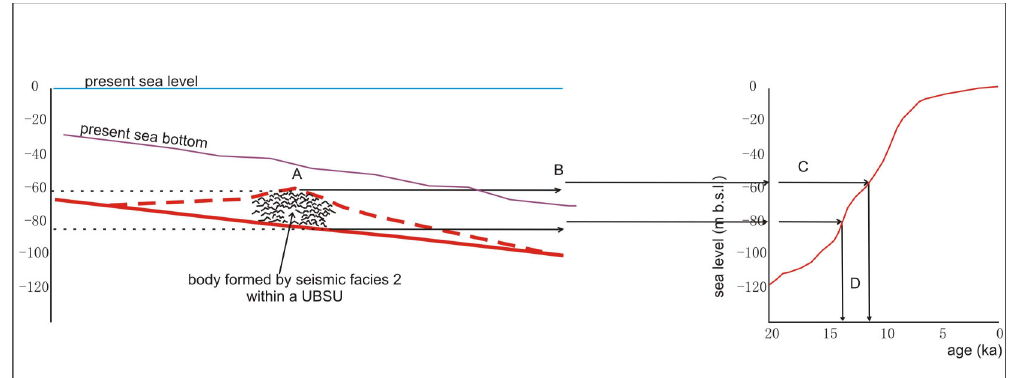
Figure 4. Conceptual sketch illustrating the method used for the approximated evaluation of the age range of the discontinuity-bounded seismic units. A: recognition of the depth below present sea level of the base and the top of the bodies formed by seismic facies 2; B: correction of these depths in order to remove the subsidence; C: projection of these corrected depths on the sea level curve considered; D: reading of the corresponding age range.